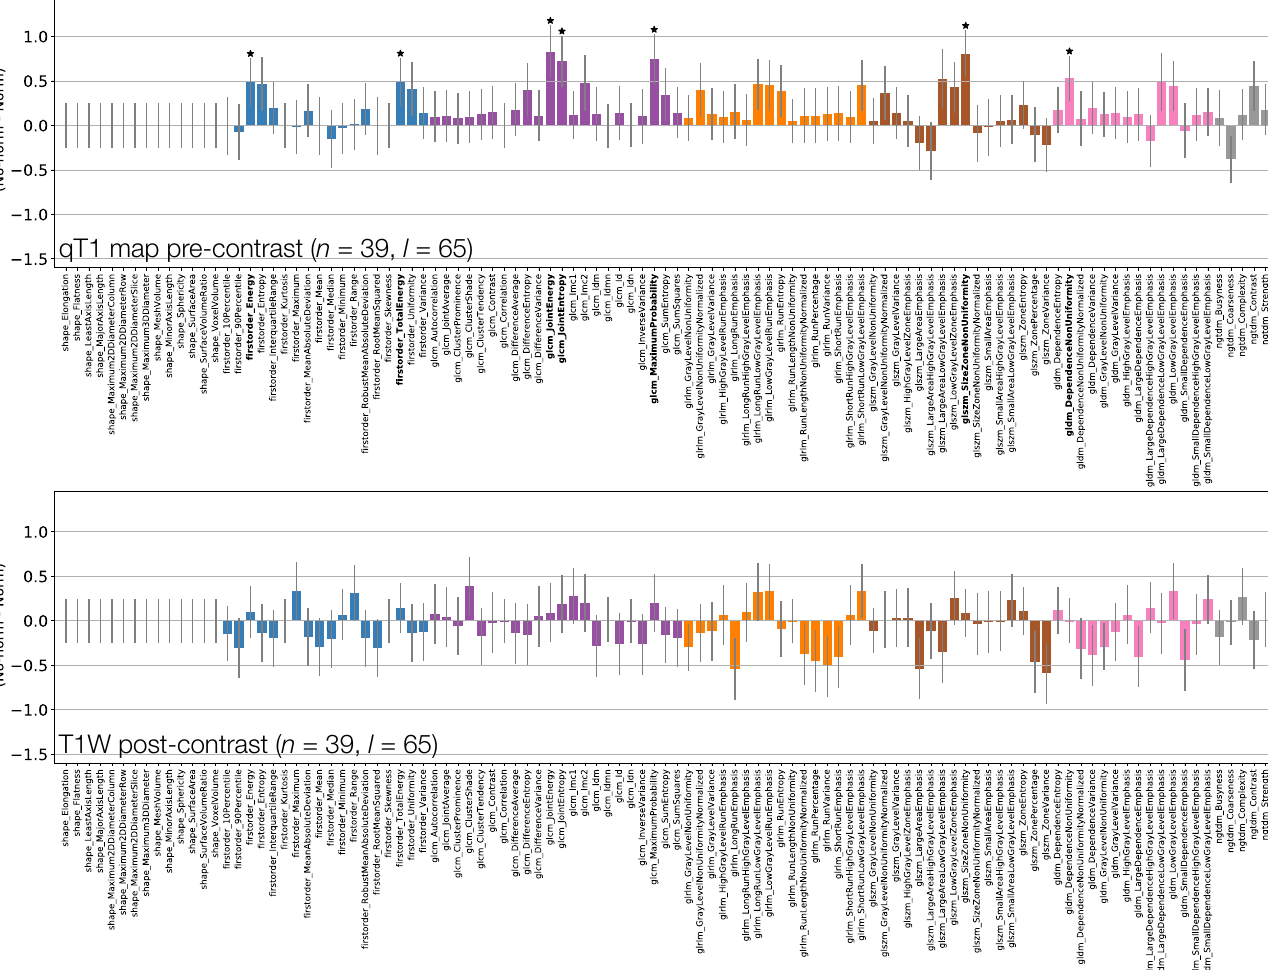
Figure 10. Effect of image normalisation on qT 1 maps and T 1 W post-contrast images. Comparison of ICCs for Box–Cox transformed features from non-normalised and normalised images, for qT 1 map pre-contrast (top) and T 1 W post-contrast (bottom). Bars represent the difference in ICC point estimates (after applying Fisher’s Z -transformation), and error bars represent 95% CIs. Features are colour coded according to their class. Black stars and bold fonts indicate features where ICCs from non-normalised and normalised images are significantly different.